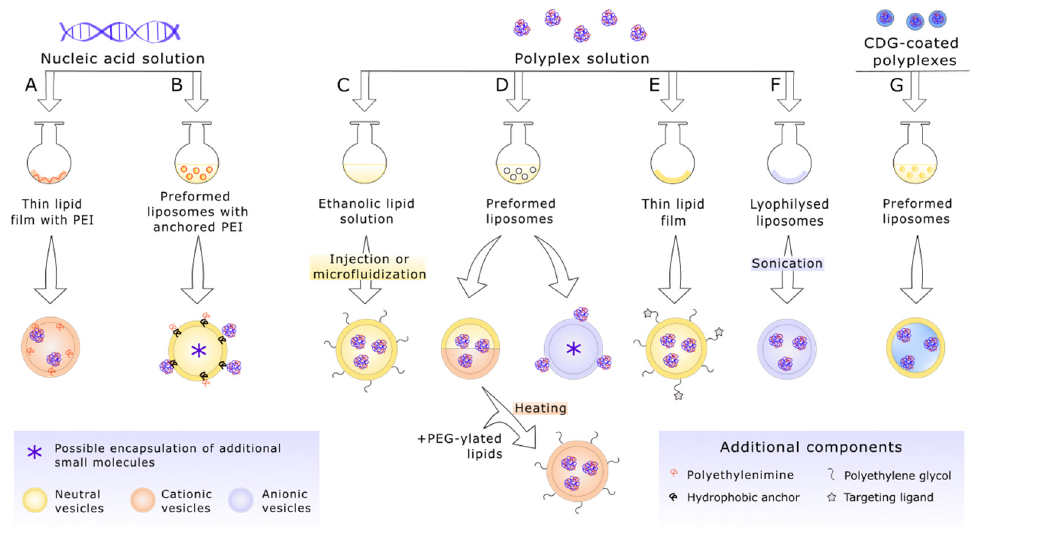
Figure 2. Possible procedures used in lipopolyplex preparation. A—Hydration of thin lipid film A—Hydration of